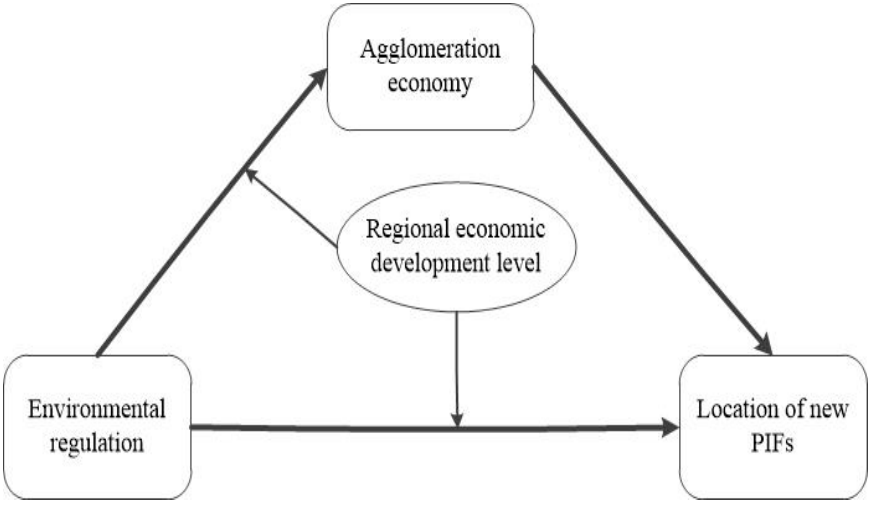
Figure 1. Influence mechanism of ER on the location of new PIFs under agglomeration effect.